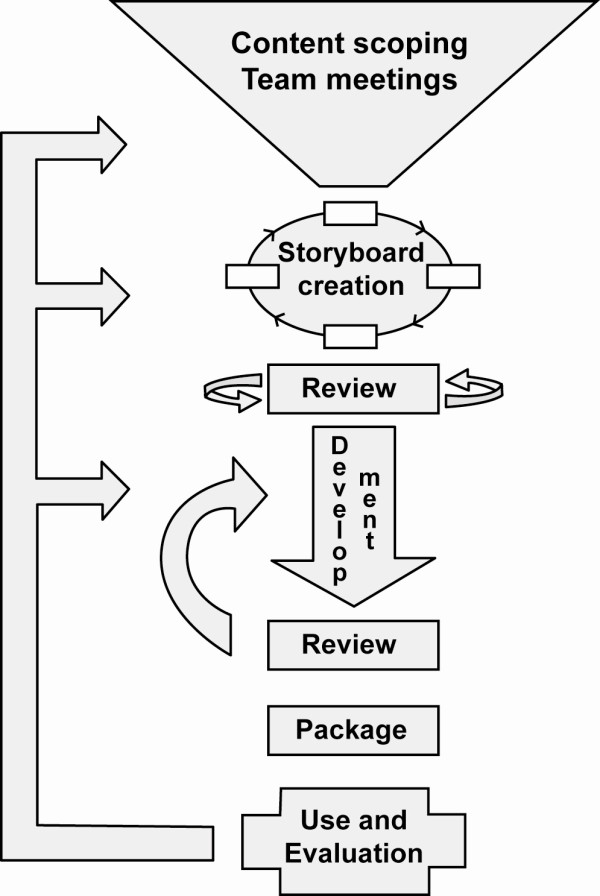
Schematic diagram showing the stages of the RLO development process. The schematic diagram shows the stages of the RLO development process beginning with team meetings to scope the content and ideas for analogies and media to illustrate the concepts. The written storyboard is sent to experts for peer review prior to development. Once a prototype has been developed, the RLOs go through a second peer review before packaging and release.